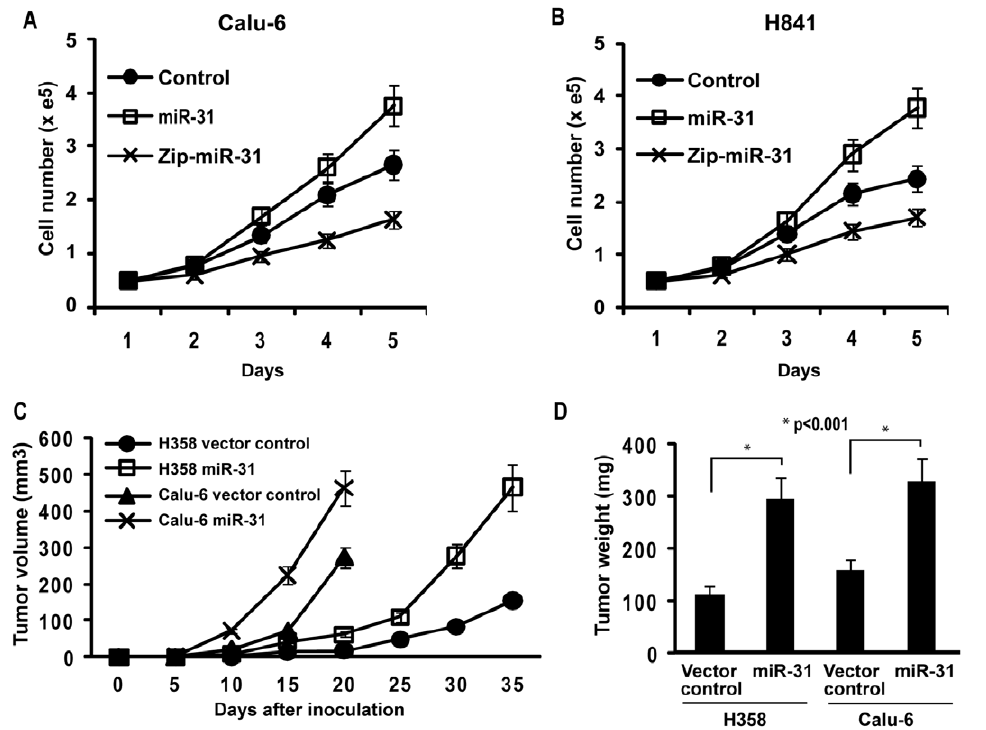
Figure 6. miR-31 functions as an oncomir in lung cancer cells. A/B) Direct cell count assays depicting in-vitro proliferation of Calu-6 and H841 lung cancer cells exhibiting over-expression or knock-down of miR-31. Constitutive over-expression of miR-31 increased proliferation, whereas knock- down of miR-31 diminished proliferation of Calu-6 (a) as well as H841 (b) cells relative to vector controls. C) Growth of H358 and Calu-6 tumor xenografts in nude mice. Calu-6 and H358 cells constitutively over-expressing miR-31 and vector controls (1 6 10 6 ) were inoculated subcutaneously in the right and left flanks of athymic nude mice. Tumor volumes were determined every five days. The mean tumor volumes are shown. Volumes of xenografts derived from Calu-6 or H358 cells over-expressing miR-31 were significantly larger than vector controls (P , 0.01). D) Tumor masses from H358 and Calu-6 xenografts. MiR-31 expression significantly increased average mass of H358 as well as Calu-6 xenografts (p , 0.001).